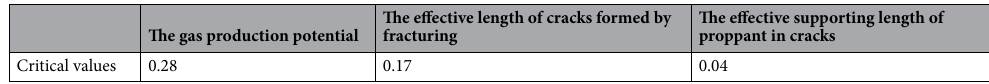
Table 3. Determination of critical value of primary evaluation index.